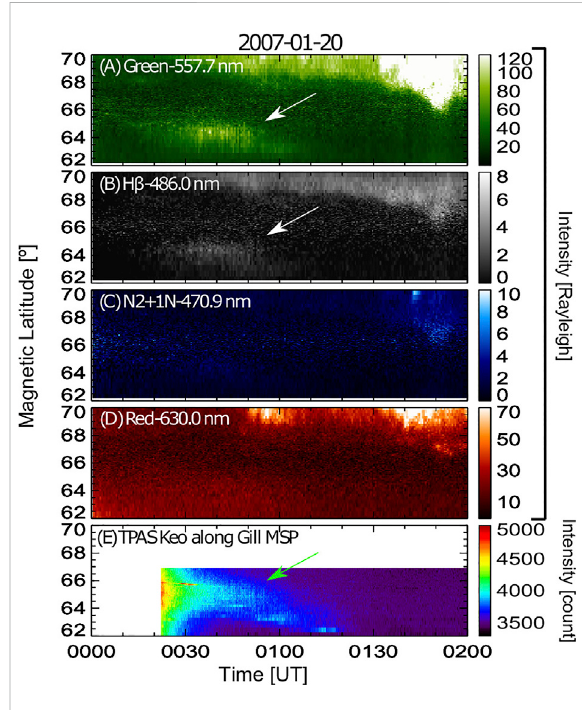
FIGURE 2 Keograms from Gillam and The Pas. (A – D) show the MSP intensity in the H β , blue, and red channels. (E) shows a keogram constructed along the MSP-GILL fi eld of view using data extracted from the THEMIS-TPAS ASI images. The matching aurora intensity in (A,B,E) con fi rm that the aurora observed by THEMIS- TPAS right after sunset was generated by